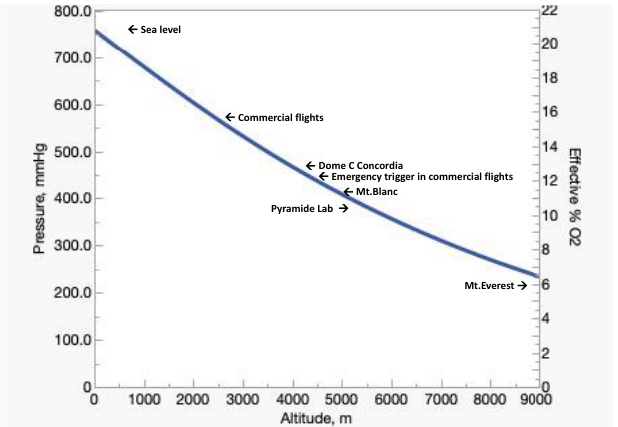
Figure 1. Behavior of the barometric pressure (left Y-axis) and of the effective %O 2 (right Y-axis) at varying altitude above sea level in the Earth atmosphere. Data from the International Standard Atmosphere (ISA). The ISA does not contain water.